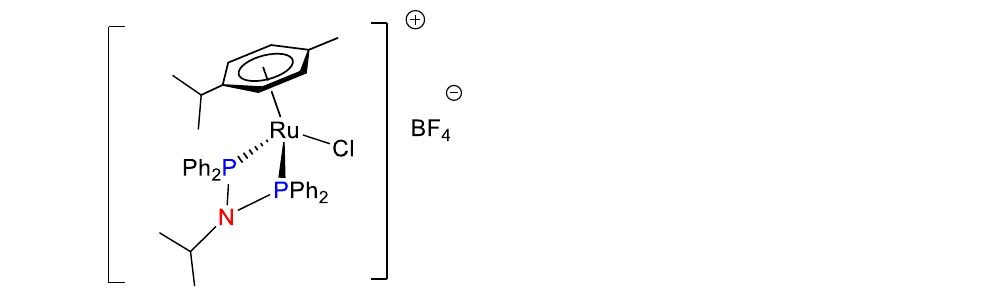
Figure 1. Chemical structure of the lead bis-phosphino-amine compound for breast cancer therapy.